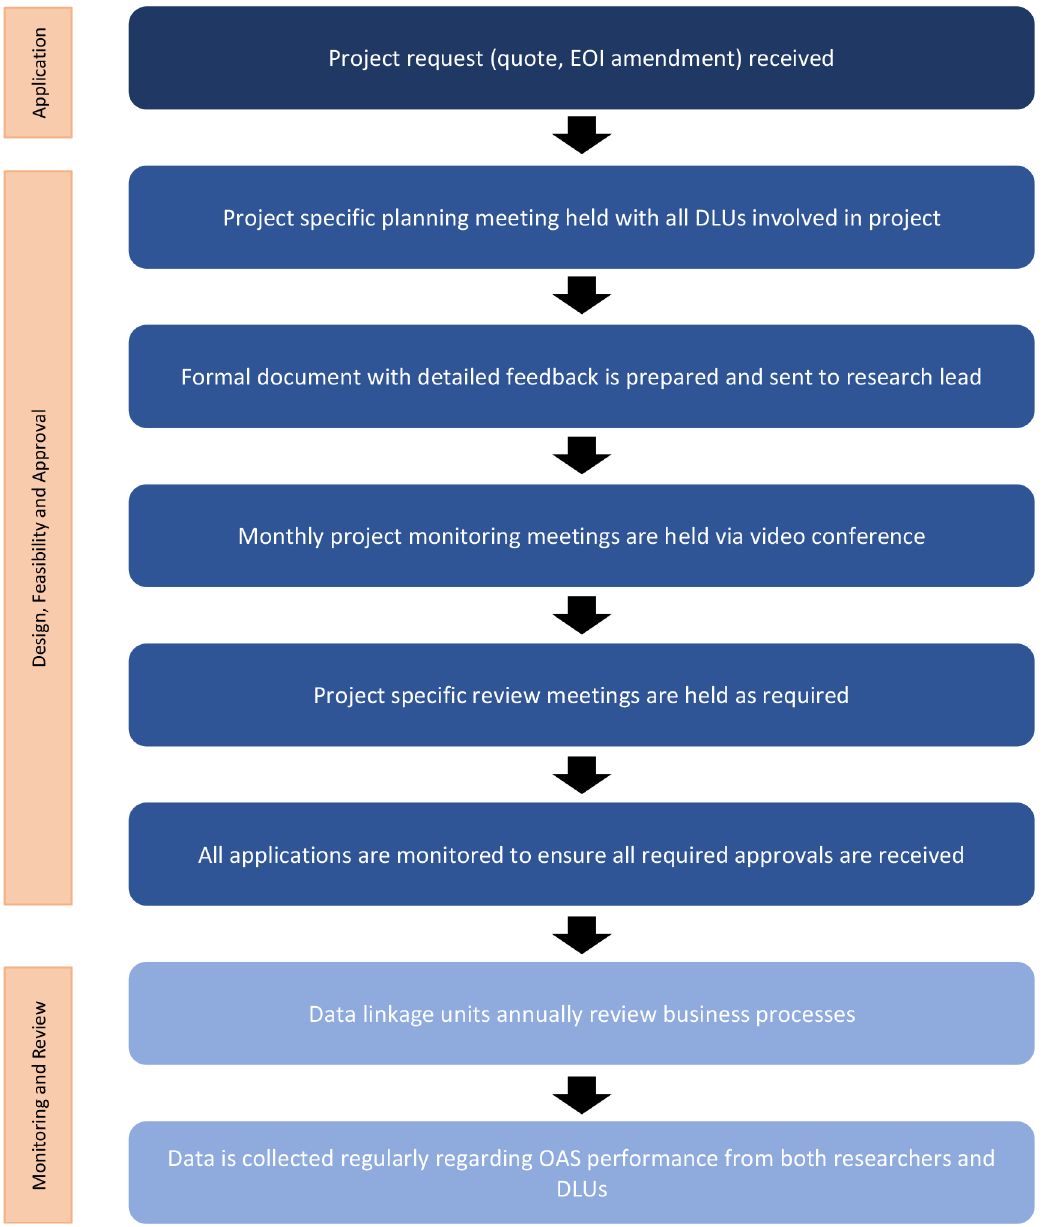
Figure 1: Cross-jurisdictional harmonised business